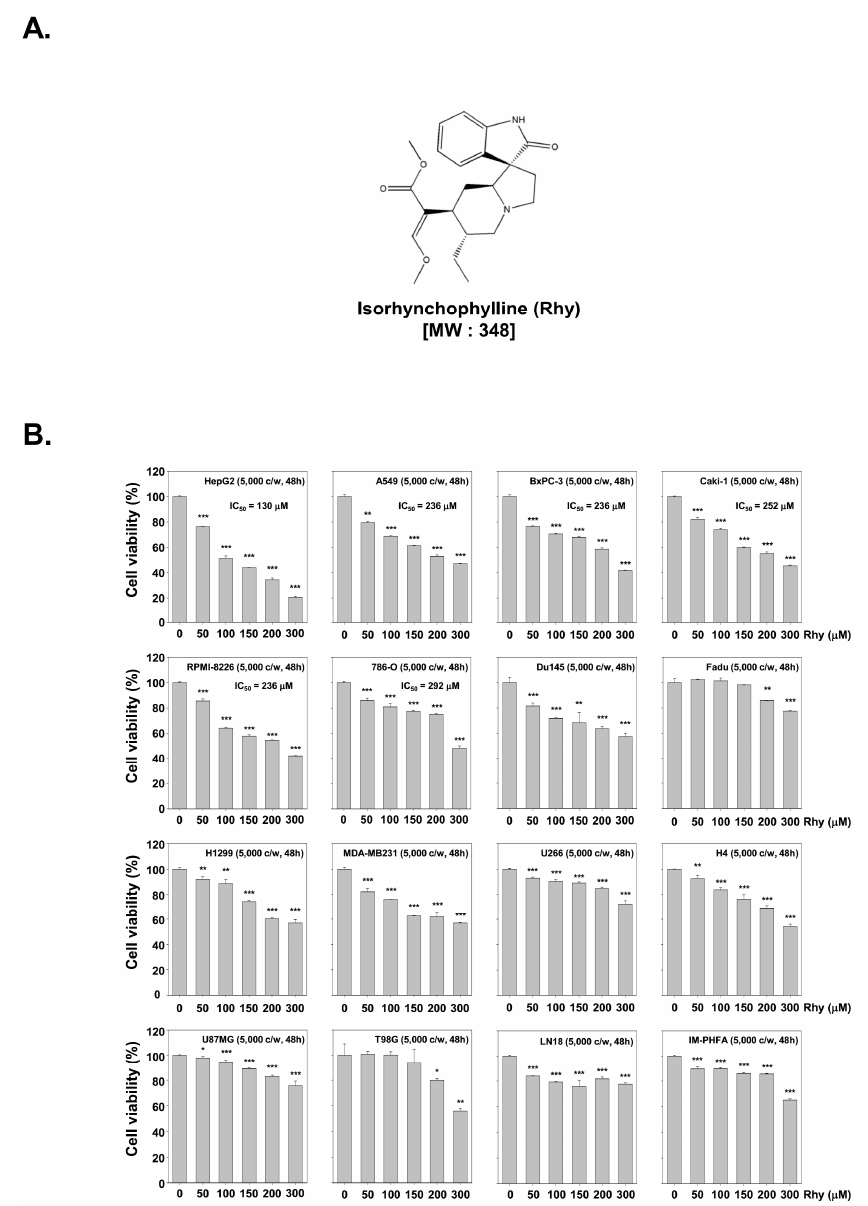
Figure 1. Cytotoxicity of isorhynchophylline (Rhy) on various cell lines: ( A ) Structure of Rhy; and ( B ) HepG2, A549, BxPC-3, Caki-1, RPMI-8226, 786-O, Du145, FaDu, H1299, MDA-MB-231, U266,